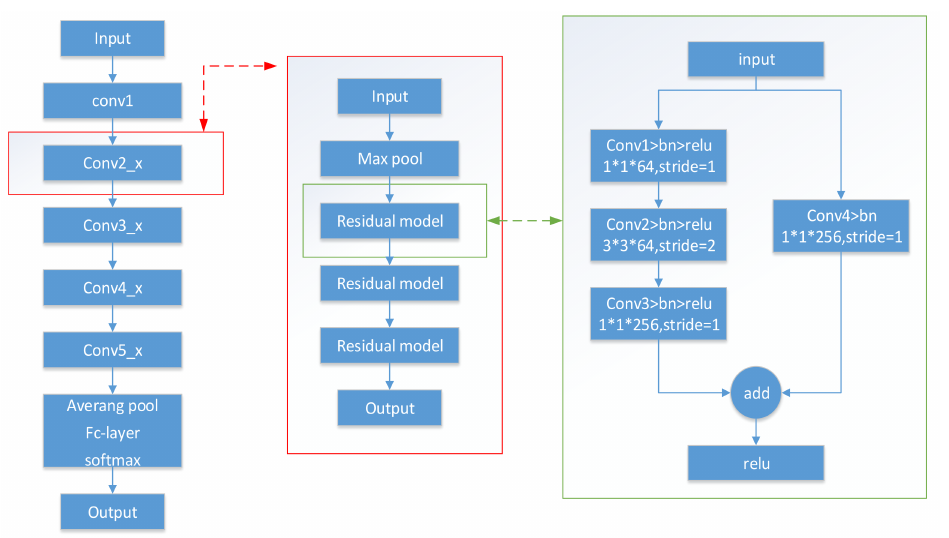
Figure 3. ResNet50